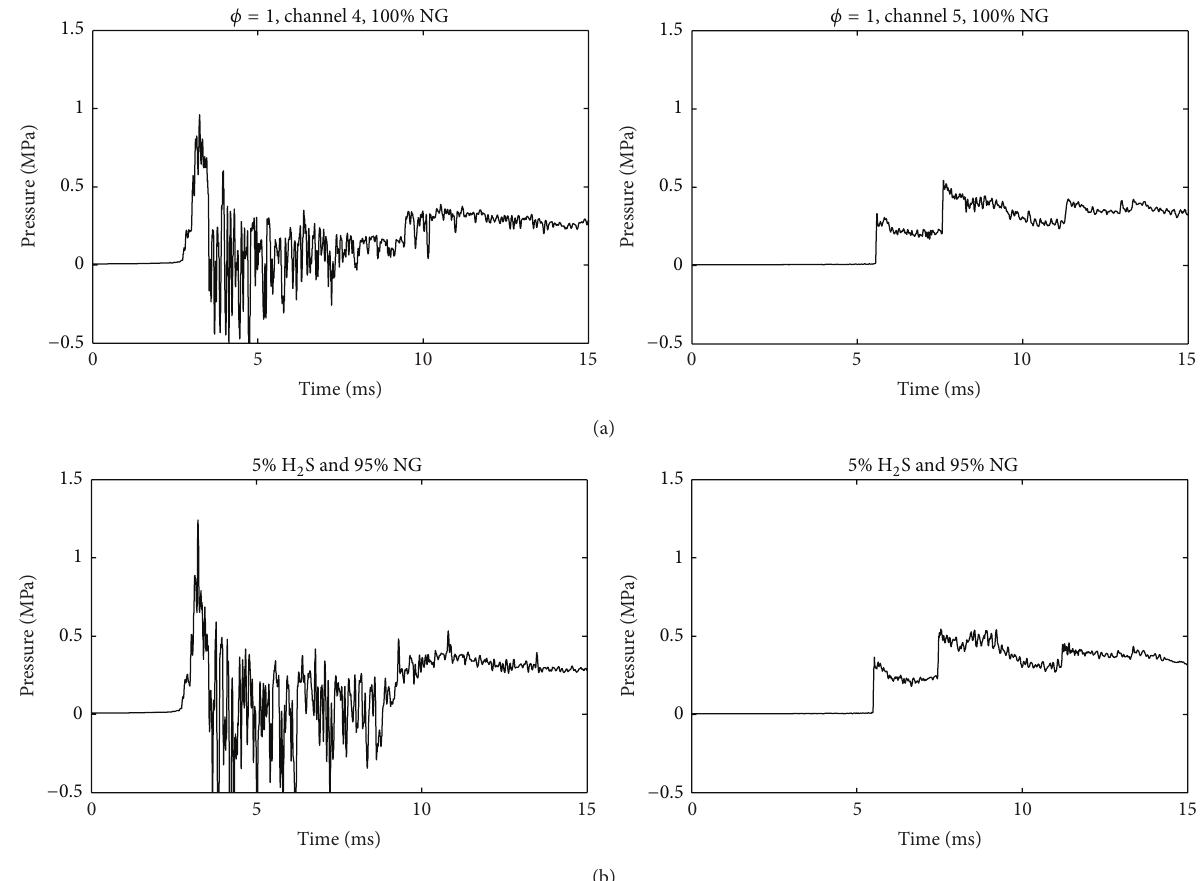
Figure 15: Comparison of explosion pressures for 𝜙 = 1 in the obstructed section (channel 4) and the smooth section (channel 5). (a) 100% NG and (b) NG with 5% H 2